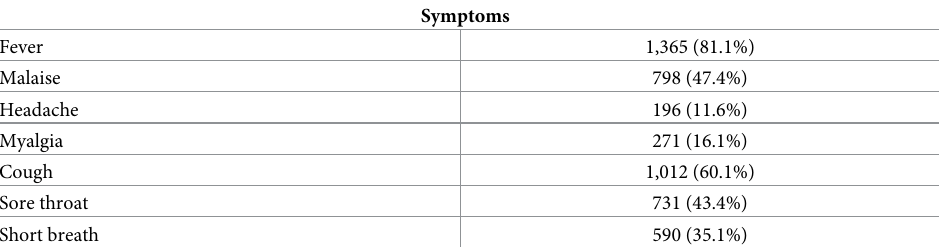
Table 2. Patients’ clinical manifestations.